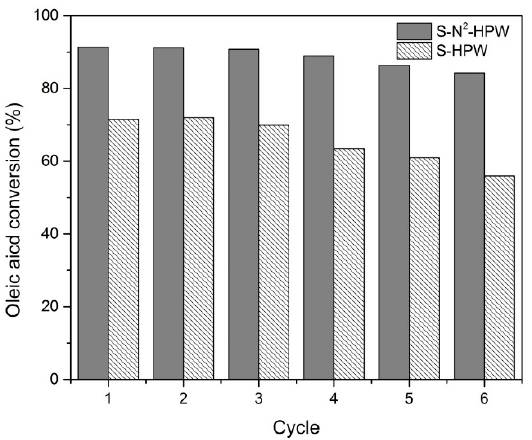
Figure 9. Effect of aminosilane functionalization on catalyst reusability using S-N 2 -HPW and S-HPW catalysts in esterification of glycerol with oleic acid for six cycles at 160 °C for 3 h per cycle with 2.5 wt % of catalyst loading and glycerol/oleic acid molar ratio of 4:1.